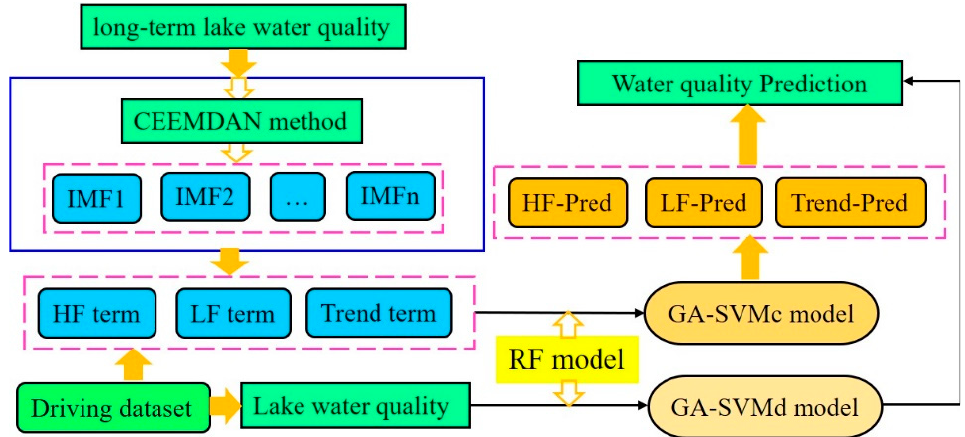
Figure 1. The two designed integrated experimental schemes. HF term and LF term represent the high-frequency and low-frequency terms. HF-Pre, LF-Pre, and Trend-Pre indicate the prediction of the high-frequency, low-frequency, and trend terms.